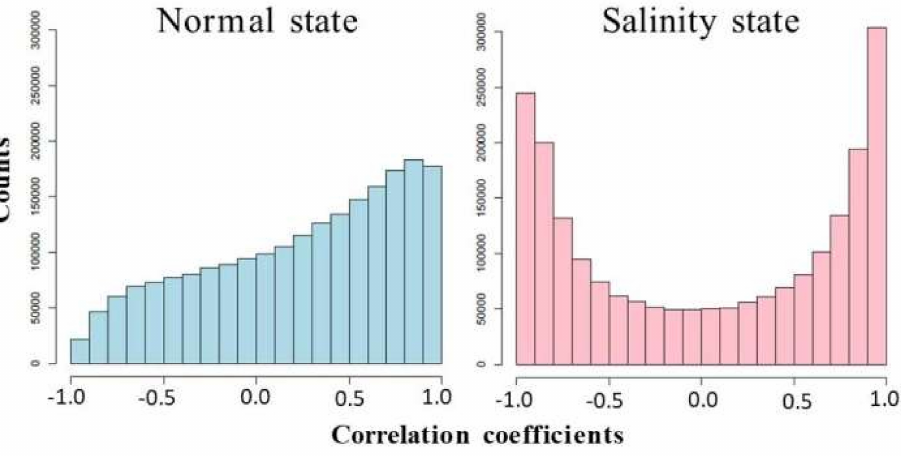
Figure 4. Distributions of correlation coefficients between the gene expression levels under normal and salinity